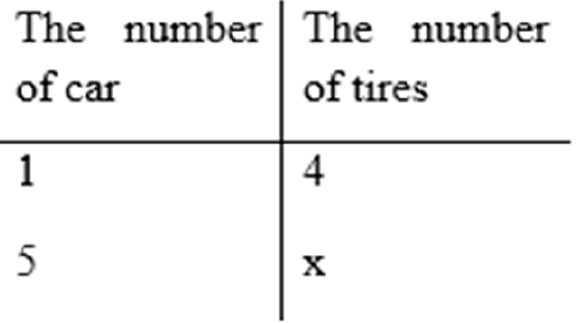
Figure 3. The representation of a multiplicative situation in Vergnaud’s T-Table. Drawing on Piaget, Clark and Kamii [18] pointed to two important difference between multiplication and repeated addition. First, multiplication involves two units each of which quantifies two distinct entities. There is a many-to-one correspondence between these units. This correspondence may be associated with Vergnaud’s [17] functional relationship,